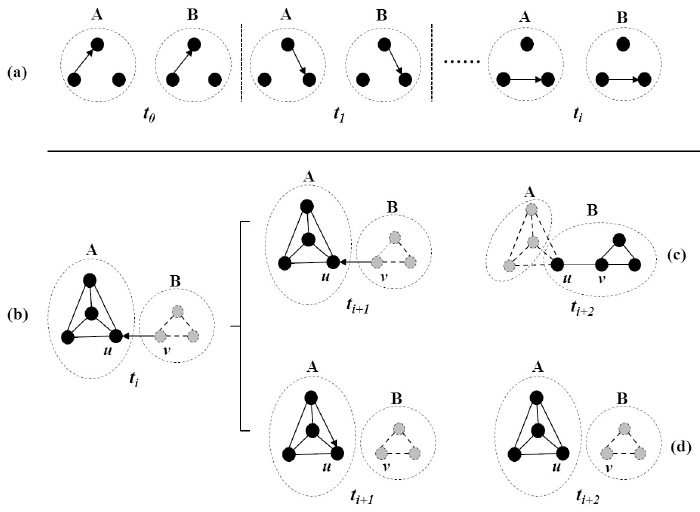
Figure 3. Two different situations in temporal networks. ( a ) shows that two communities A and B share the same information exchange within community, the corresponding nodes are of the same importance but belong to different communities. ( b ) shows that nodes u and v are in different communities in the beginning and v sends a message to u at time t i . If v sends a message to u again at t i + 1 , as shown in ( c ), u will have a higher probability of belonging to B at t i + 2 than those nodes inside A send a message to u at t i + 1 , which is illustrated in ( d